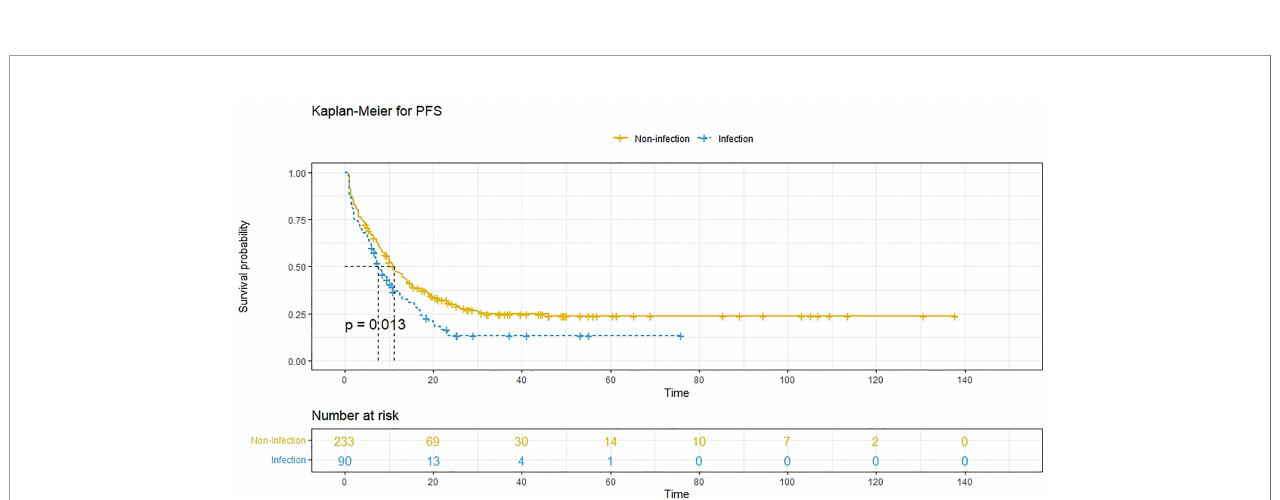
FIGURE 3 | Progression-free survival (PFS) comparison after propensity score matching in patients with postoperative infectious complications (blue line) and patients without postoperative complications (yellow line). Infection, with postoperative infective complication. Non-infection, without postoperative infective